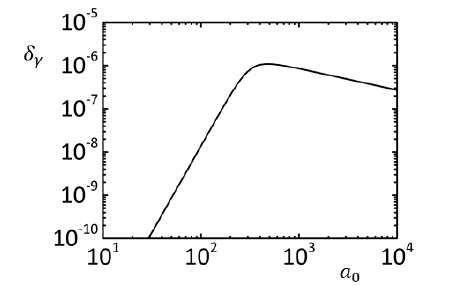
Figure 3. The relative difference between the Lorentz factor calculated from the LAD with and without the Schott term, δ γ , for b 0 = 0 and ε (cid:39) 1.18 × 10 − 8